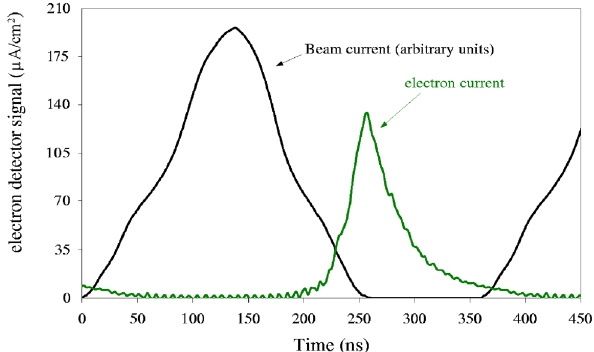
FIG. 6. (Color) Measured electron detector (ED02X, located at the injection region) signal at the